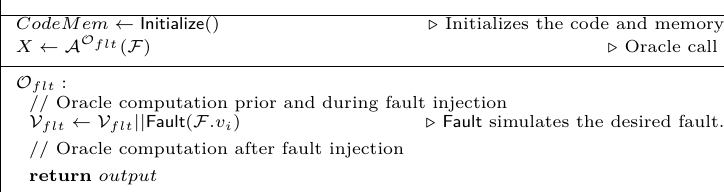
Table 2: Interaction between faulting adversary and oracle